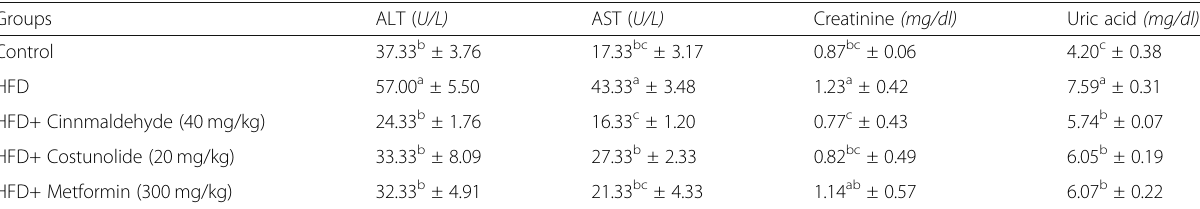
Values are means ± SE Means carrying different superscripts considered significant ( P < 0.05)